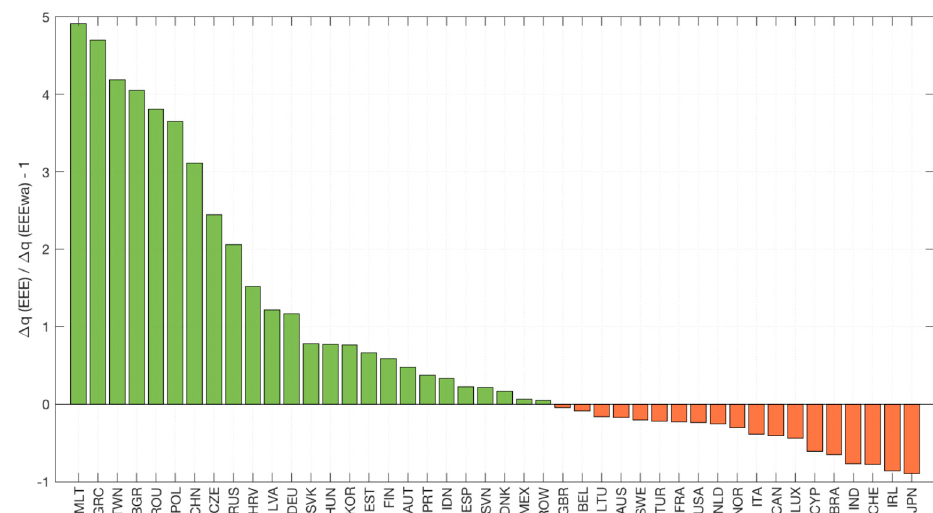
Figure 3. Emissions reductions due to technology changes with domestic emission factors compared to world average, [ 𝐪 (EEE)/ 𝐪 (EEEwa)] – 1.